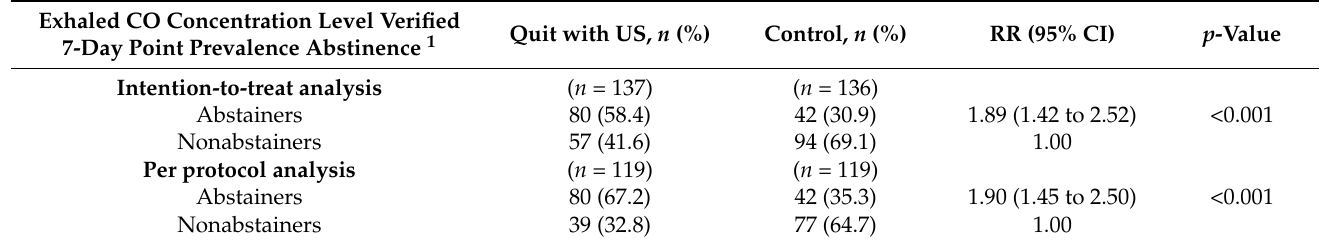
Table 2. Primary outcome in the Quit with US trial.